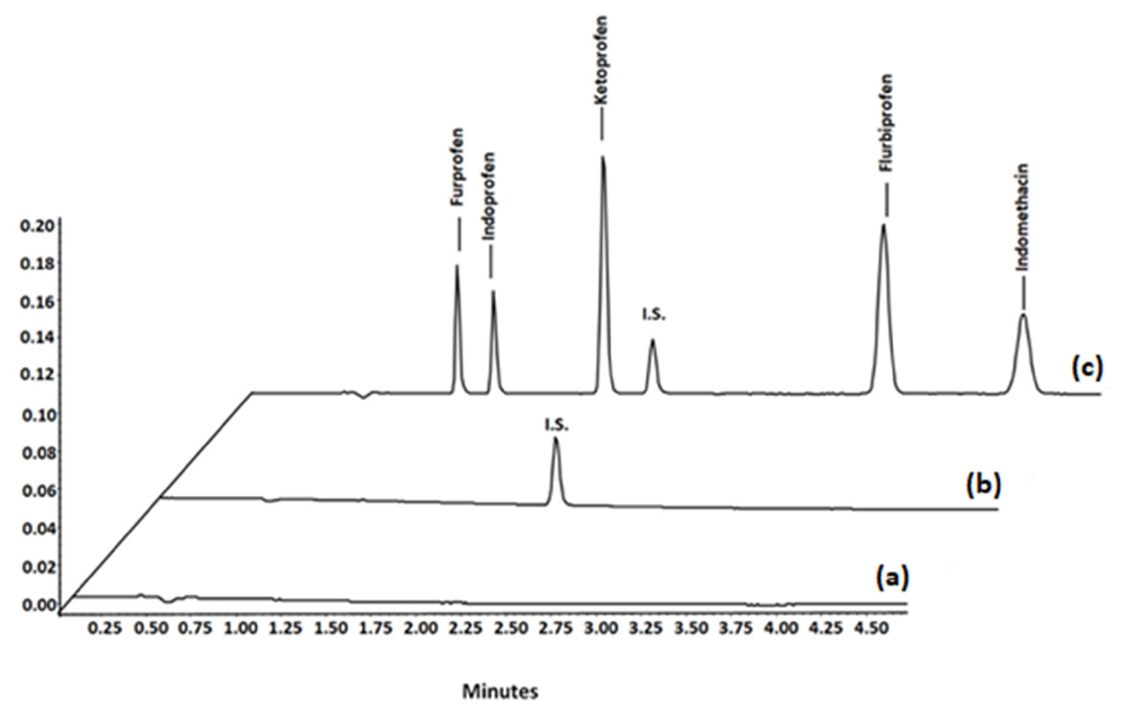
Figure 7. UHPLC chromatograms of samples subjected to the proposed MSPE method: (a) blank plasma samples; (b) blank plasma samples spiked with internal standard; (c) blank plasma spiked with I.S. and the investigated NSAIDs.